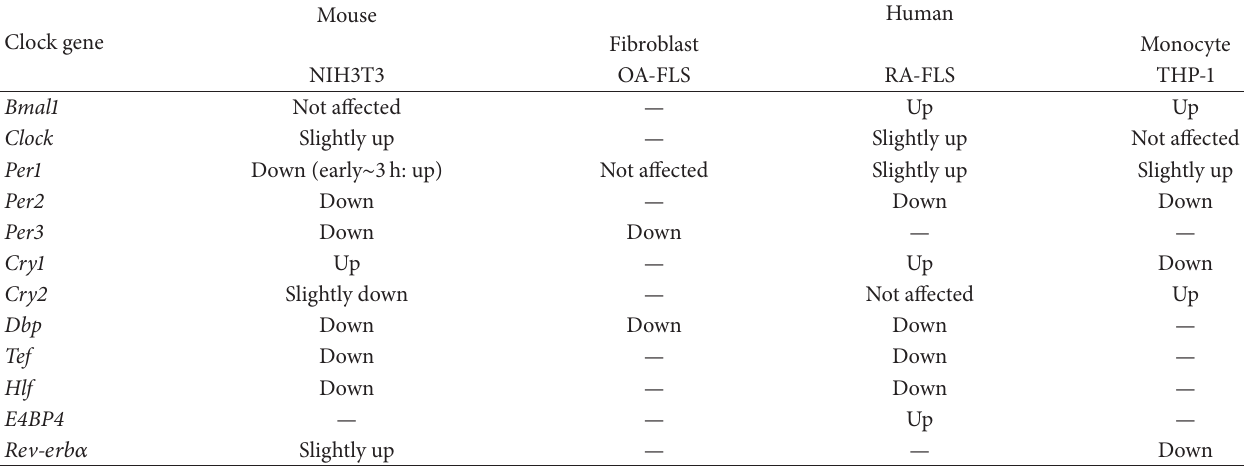
∗ Based on results of the refer 49–53. — denotes no data. OA-FLS: osteoarthritis fibroblast-like synovial cells. RA-FLS: rheumatoid arthritis fibroblast-like synovial